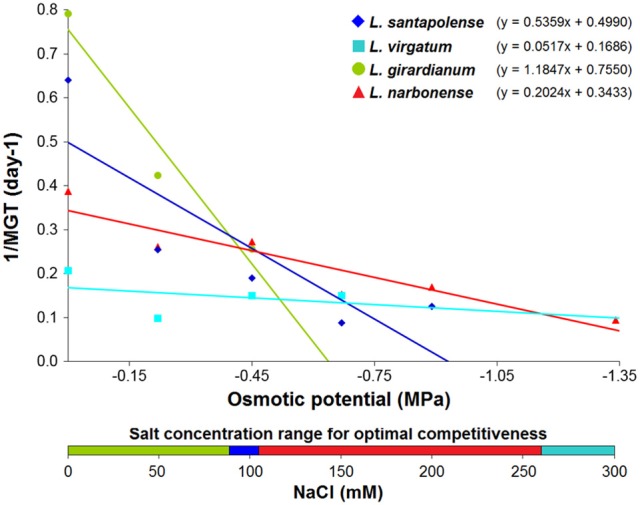
Progression of the germination velocity in relation to the osmotic potential of the germination medium, generated by the applied NaCl concentrations, in the four Limonium species. The bottom bar represents the salt concentration ranges corresponding to higher competitiveness for each species, determined by the intersection points of the regression lines.